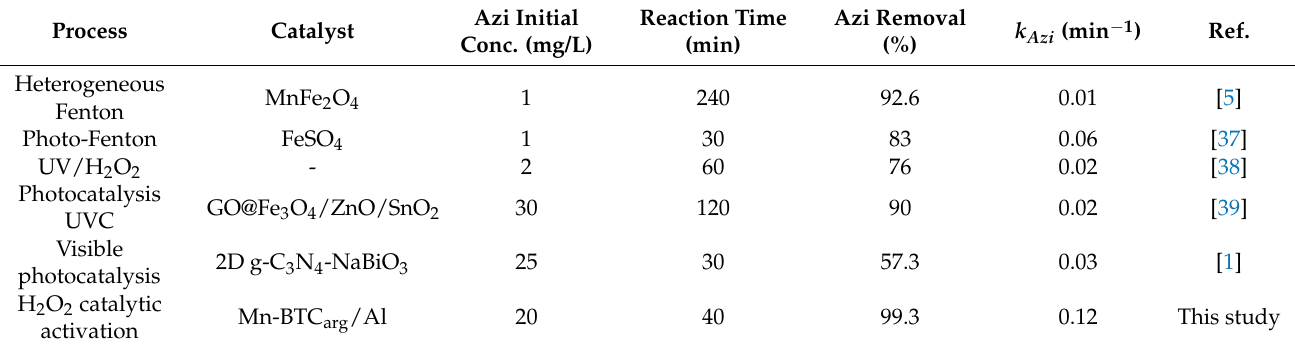
Figure 10. Kinetic plot of the Azi removal; pH = 5, Mn-BTC arg /Al catalyst dosage of 6 g/L and H 2 O 2 concentration of 1 g/L. Table 4. Comparison of the Azi removal results of other works with this